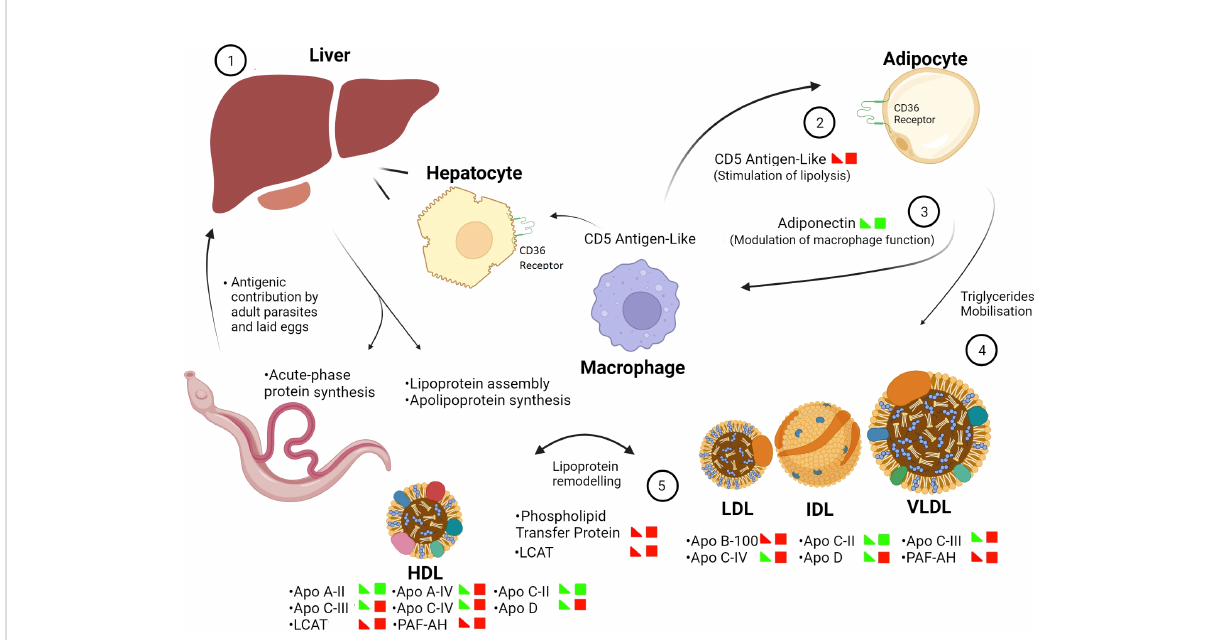
FIGURE 7 Proposed model for lipid metabolism regulation during schistosomiasis and the in fl uence of macrophage and adipose tissue-secreted molecules. Up or down regulation of proteins are represented by half and full squares, meaning the 5 th and 7 th week post-infection periods, respectively. Colored squares indicate downregulation (green) or upregulation (red). 1) The liver responsible for lipoprotein assembly, apolipoprotein synthesis and overall metabolism receives the antigenic burden associated with adult parasites and laid eggs leading to pronounced changes in protein expression. Macrophages are a hallmark of in fl ammation during schistosomiasis 2) CD5 antigen-like, mostly secreted by macrophages, can be internalised on hepatocytes and adipocytes through CD36 receptors. 3) Reduced levels of adiponectin secreted by adipocytes contribute to modulate macrophage function and maintenance of the in fl ammatory status. Adiponectin also in fl uences the serum levels of HDL-C and triglycerides. 4) CD5 antigen-like stimulates lipolysis with consequent triglyceride mobilisation. 5) Altered levels of apolipoproteins and upregulated levels of lipoprotein modifying enzymes (phospholipid transfer protein and LCAT) suggests pronounced lipoprotein remodelling during S. mansoni infection. Created with